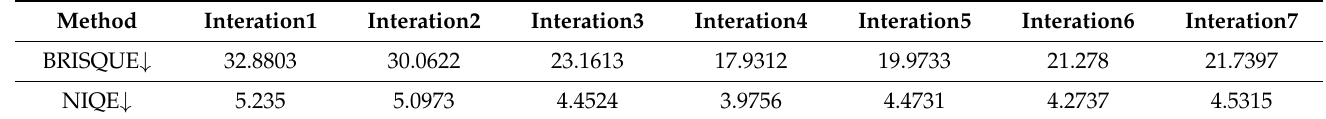
Table 7. Metric values of the enhanced result set for different number of